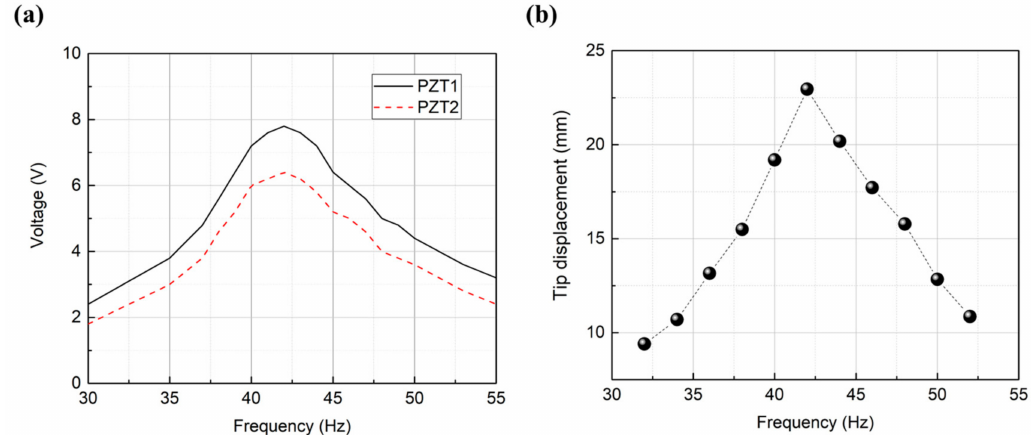
Figure 5. ( a ) Voltage characteristics of the PZTs, ( b ) tip displacement of the piezoelectric energy harvester (PEH) as a function of the